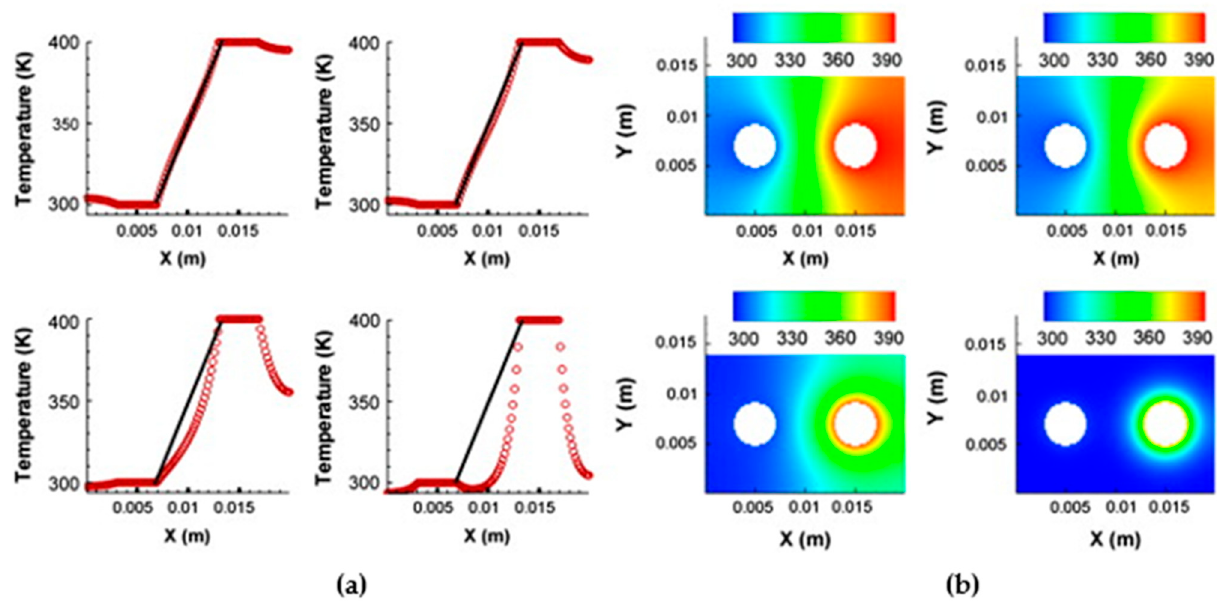
Figure 9. Temperature distribution along the longitudinal section of the fin ( a ) and over the whole surface ( b ) for increasing air heat transfer coefficient from 10 W m -2 K -1 to 10.000 W m -2 K -1 from top surface ( b ) for increasing air heat transfer coefficient from 10 W m − 2 K − 1 to 10.000 W m − 2 K − 1 from to bottom and from left to right [44]. top to bottom and from left to right